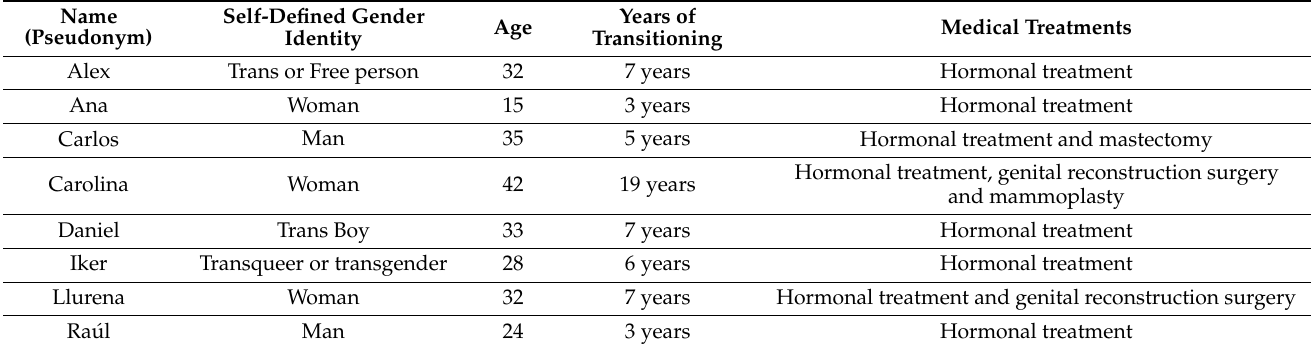
Table 1. Overview of interviewees’ genders, age and information about their medical